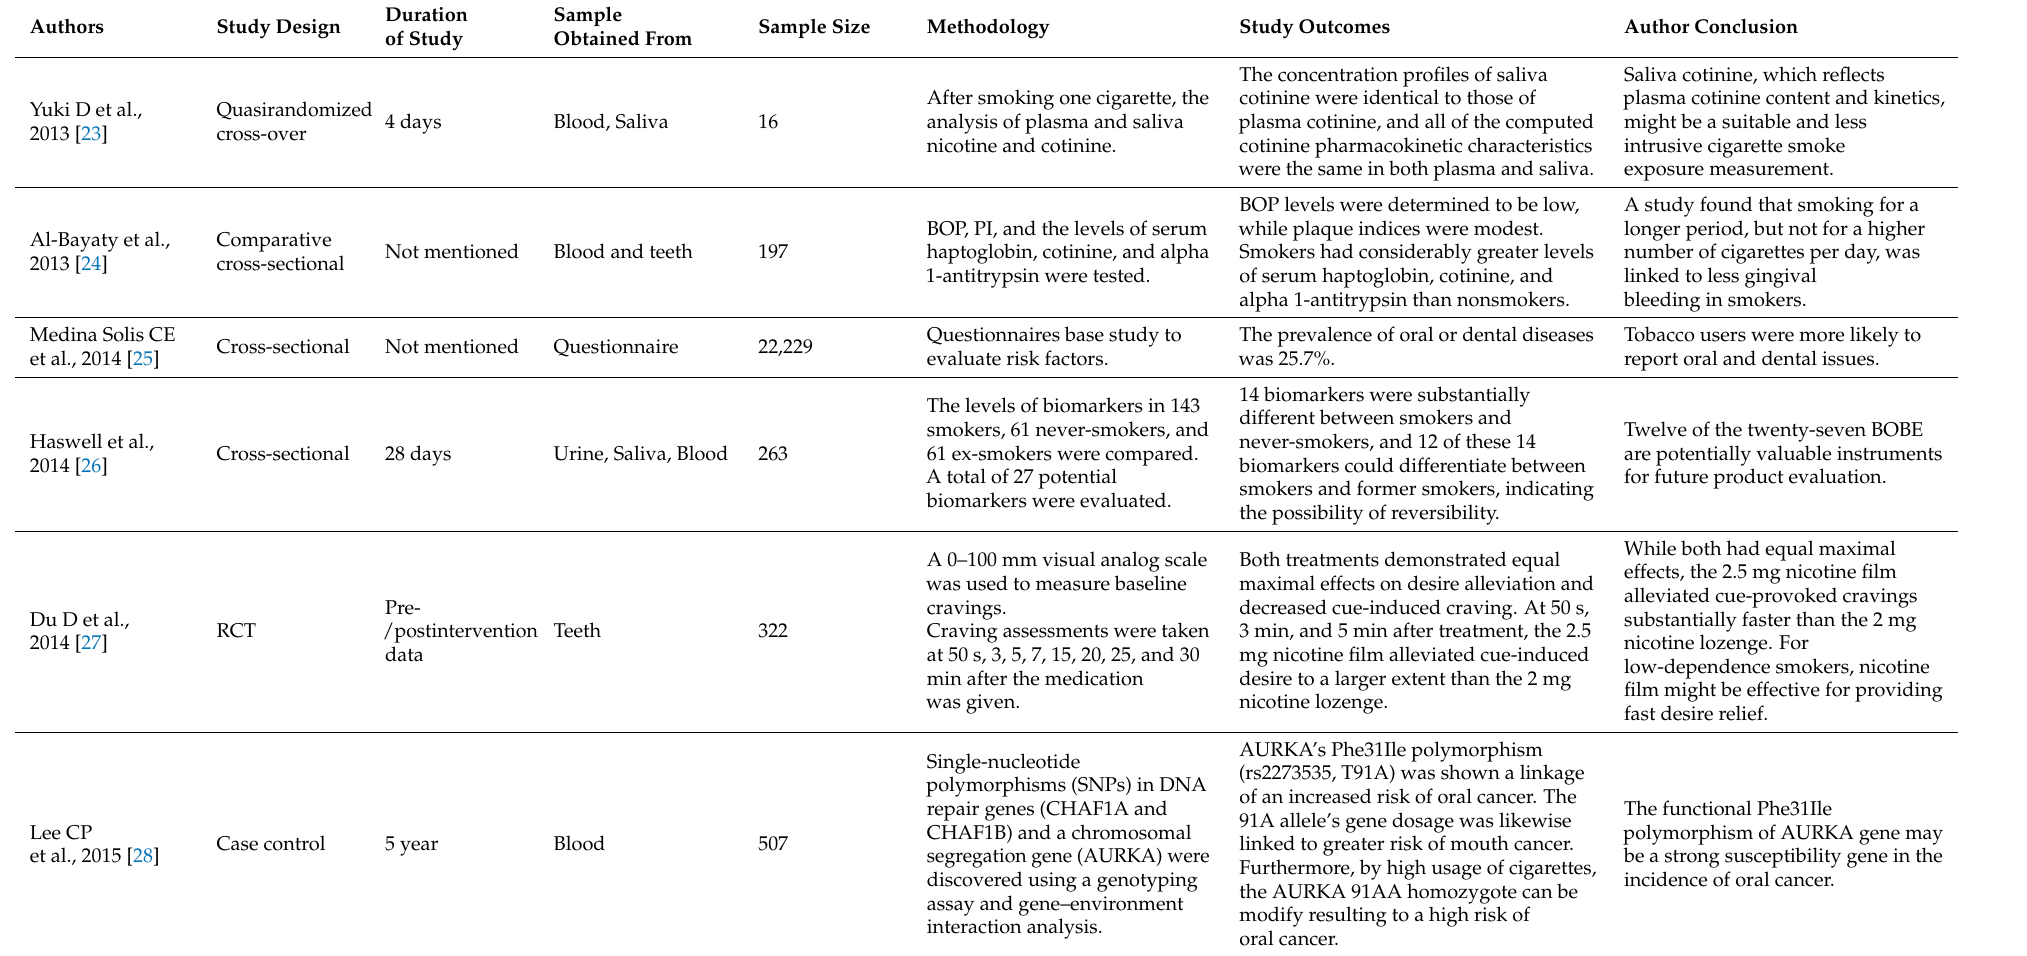
Table 3. Methodology, outcomes, and conclusion of articles included in the current